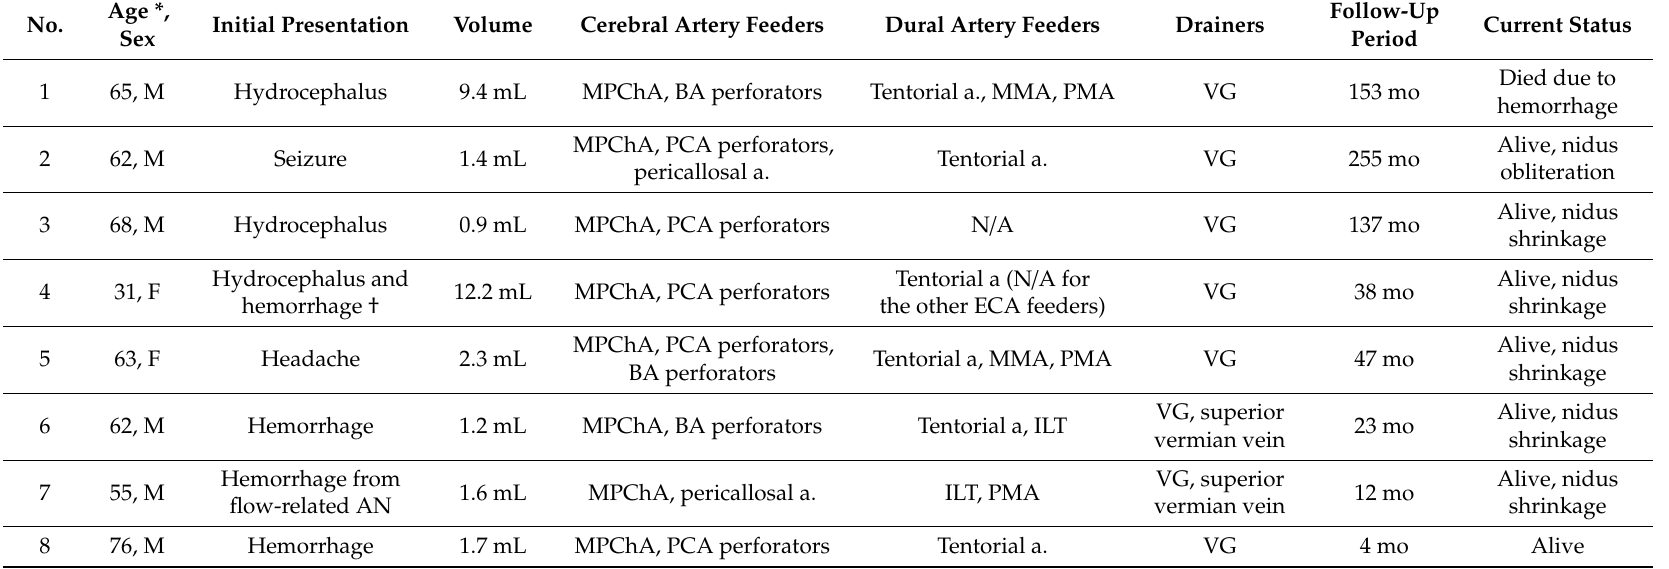
Table 1. Patient clinical and angioarchitectural